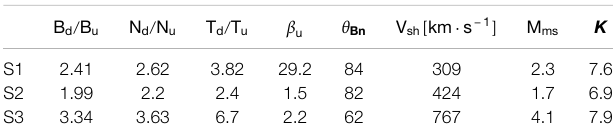
TABLE 1 | Parameters of the shocks S1, S2, and S3 at 1AU as measured by Wind; parameters are taken from the database of http://ipshocks. fi . B d / B u , N d / N u , and T d / T u are the ratios of downstream/upstream magnetic fi eld magnitude, proton number density, and proton temperature, respectively. V sh is the shock speed in the spacecraft frame of reference, M ms is the fast magnetosonicMach number and K isthe time conversion constantestimated from the shock parameters by Eq. 4 .